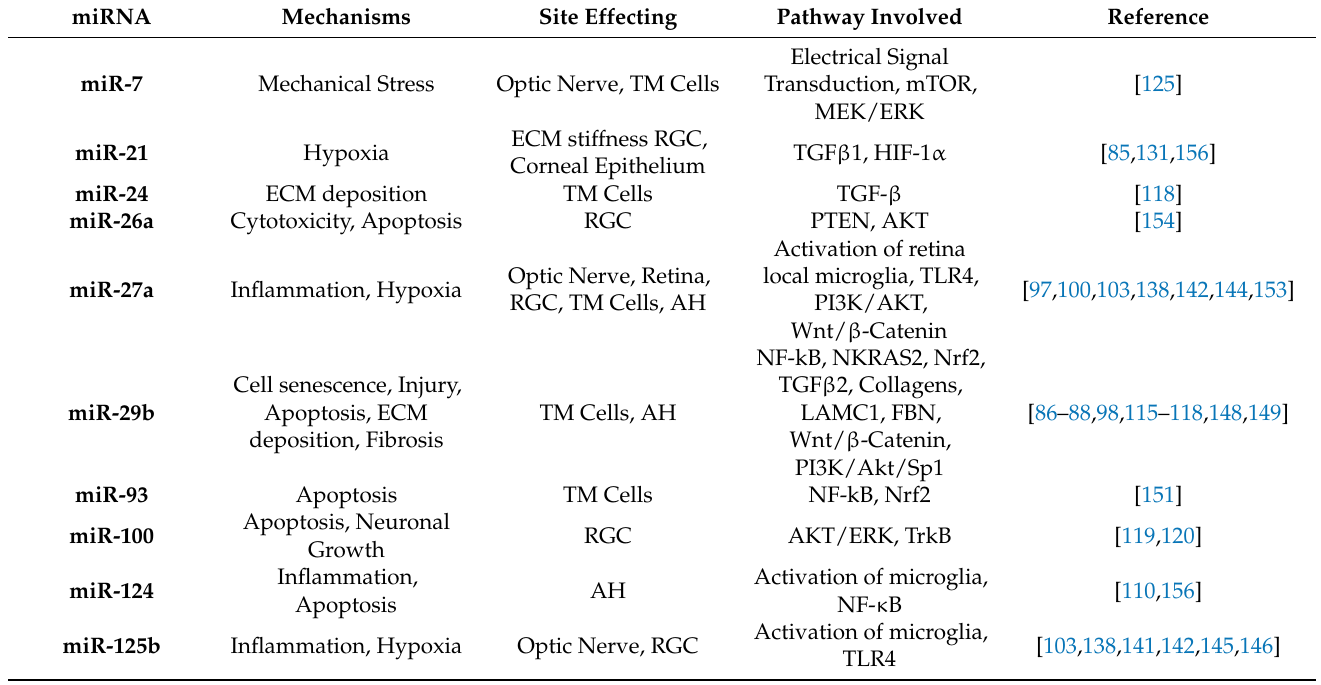
Table 1. Mechanisms of microRNAs (miRNAs) in primary open-angle glaucoma (POAG).